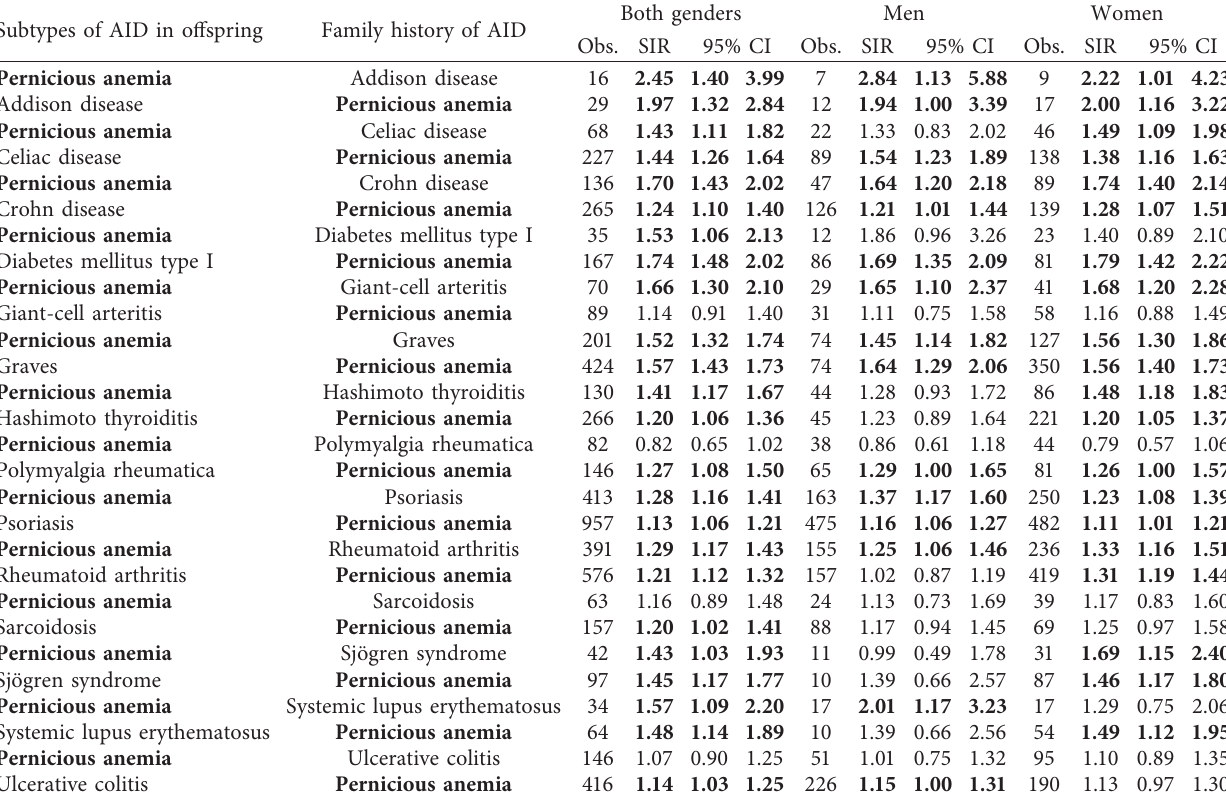
Table 3: Familial risks of discordant autoimmune